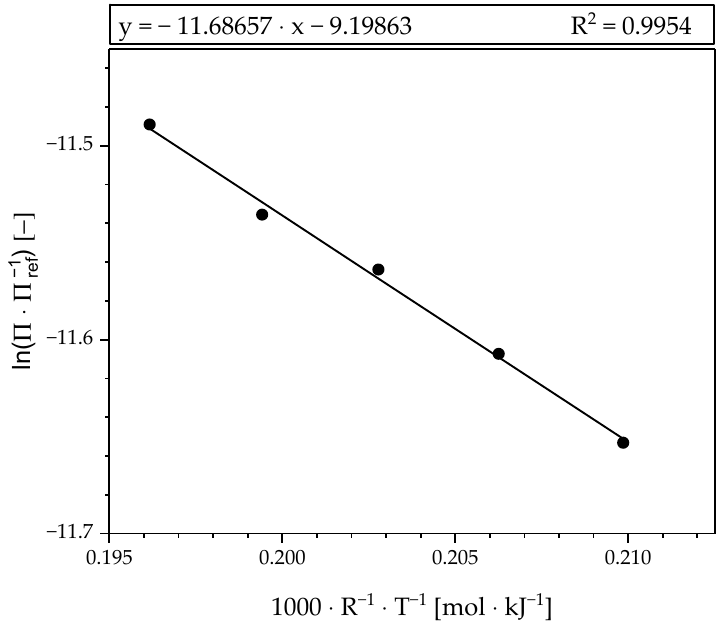
Figure 8. Arrhenius plot of the fitted permeances from the Sieverts plot for n = 0.9. Table 1. Measured activation energy and pre-exponential factor from membrane characterization experiments.